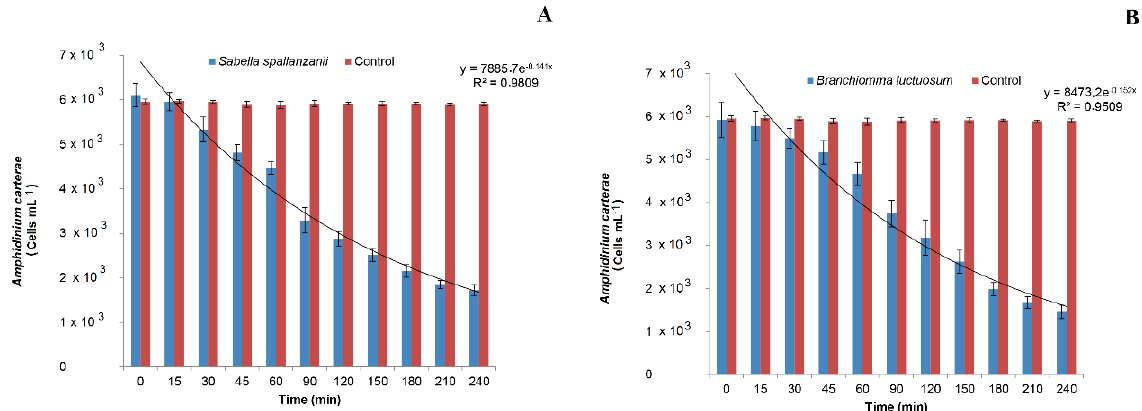
Figure 2. Changes in Amphidinium carterae abundances measured in the control and treatment beakers with ( A ) Sabella spallanzanii and ( B ) Branchiomma luctuosum .